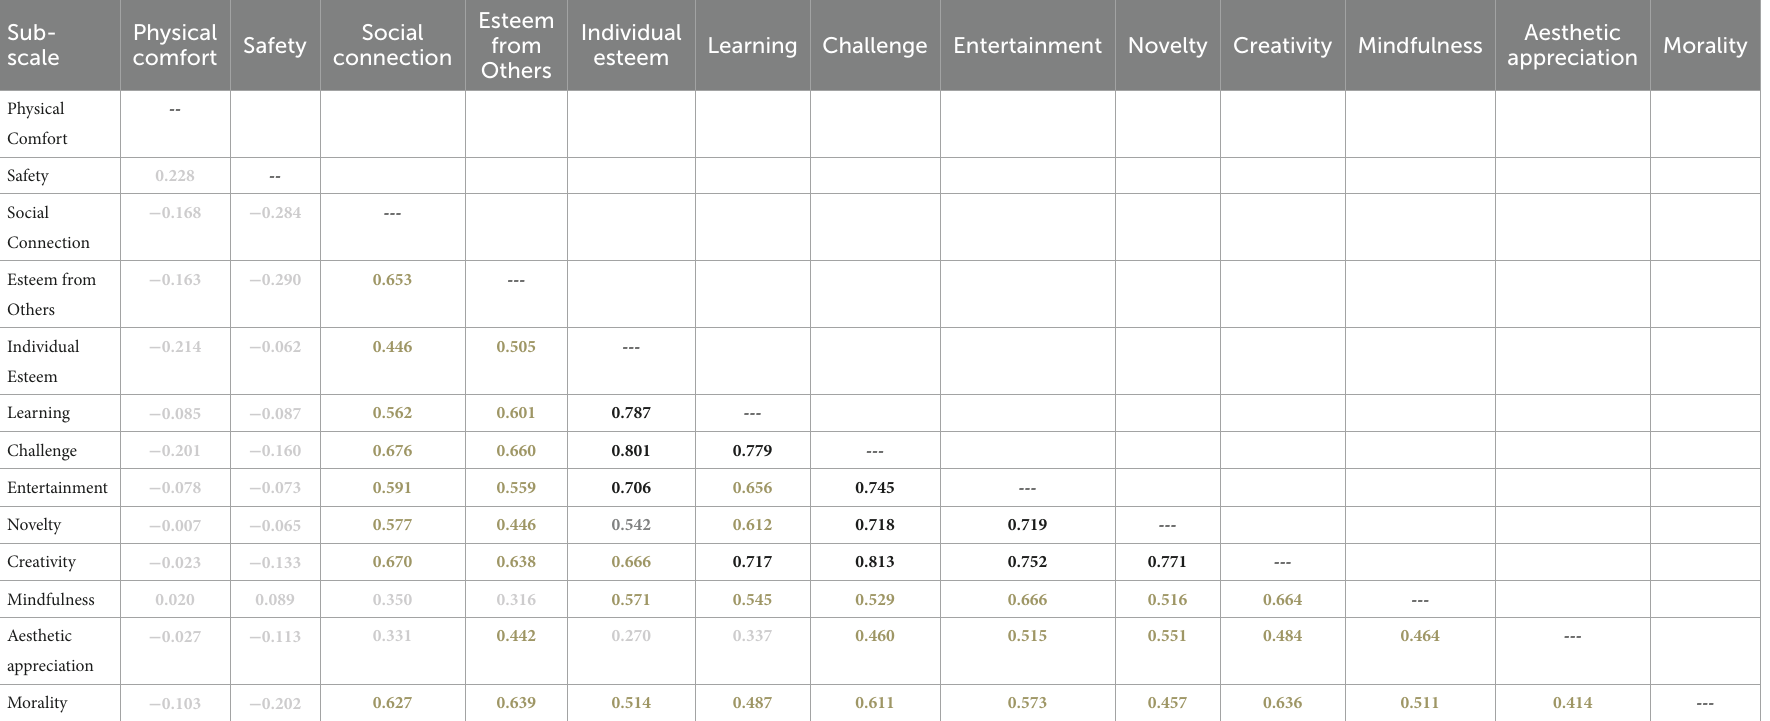
TABLE 3 Intercorrelations among psychological needs satisfied through physical activity. Esteem Sub- Physical Social Individual Safety from Learning scale comfort connection esteem Others